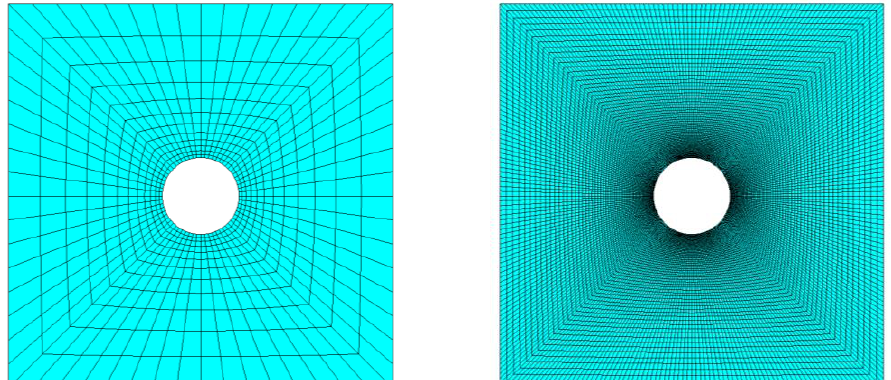
Figure 2. Geometry of the drilled plate.